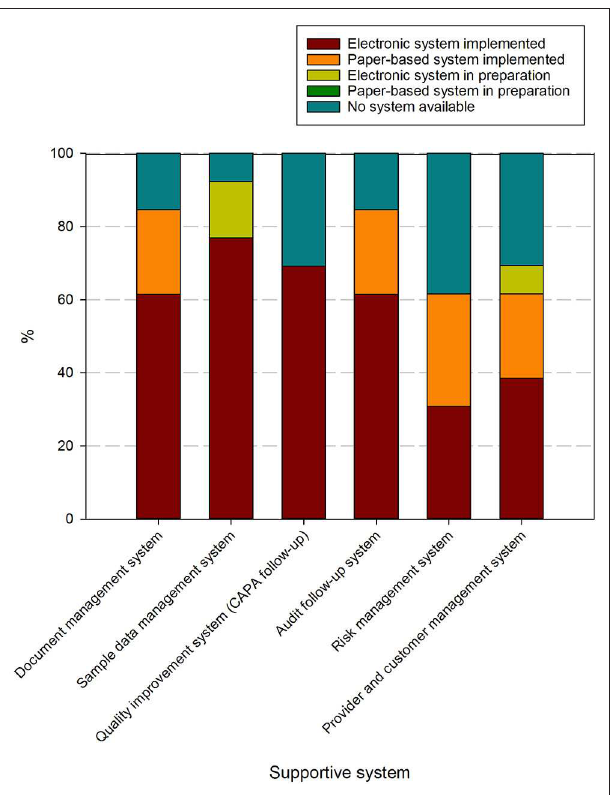
FIGURE 6 | Overview of systems used to support activities in biobanks in the BBMRI.be network. Participants were asked to indicate in a list for which supportive tools for the QMS an electronic system was implemented (brown), a paper-based system was implemented (orange), an electronic system was in preparation (lime-green), a paper-based system was in preparation (dark green), or no system was available (petrol blue). All participants responded to all items listed. The list of items asked is displayed in the